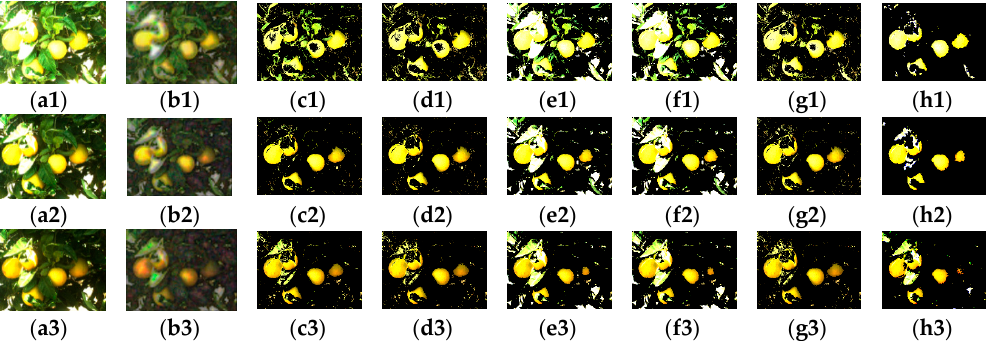
Figure 9. Example of validation, ( a1 ) is normal color image (VIS); ( b1 ) is scaled modified color image of ( a1 ); ( a2 ) is neutral density attenuated color image (NEUT); ( b2 ) is modified color image of ( a2 ); ( a3 ) is linear polarizer attenuated color image (POLA); ( b3 ) is modified color image of ( a3 ); ( c1 – c3 ) are the results by ‘R-B’ for images ( a1 – a3 ); Respectively ( d1 – d3 ) are the results by ‘2R-G-B’; ( e1 – e3 ) are the results by PCA using R, G, and B; ( f1 – f3 ) are the results by PCA using R, G, B, and NIR component; ( g1 – g3 ) are the results by FLDA; ( h1 – h3 ) are the results by the nonlinear fusion method. Table 3. F measure for classified results with different linear methods and nonlinear fusion method. F Measure by Methods ( α = 0.98–0.99)